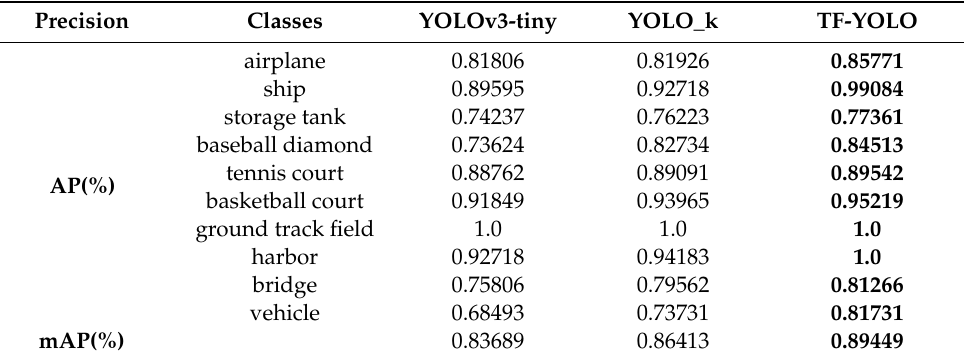
Table 2. Comparison of the accuracy of the three networks.